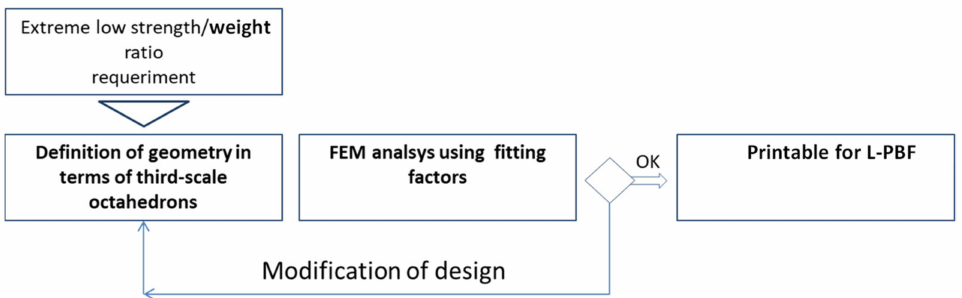
Figure 14. Proposed method for design using third-scale